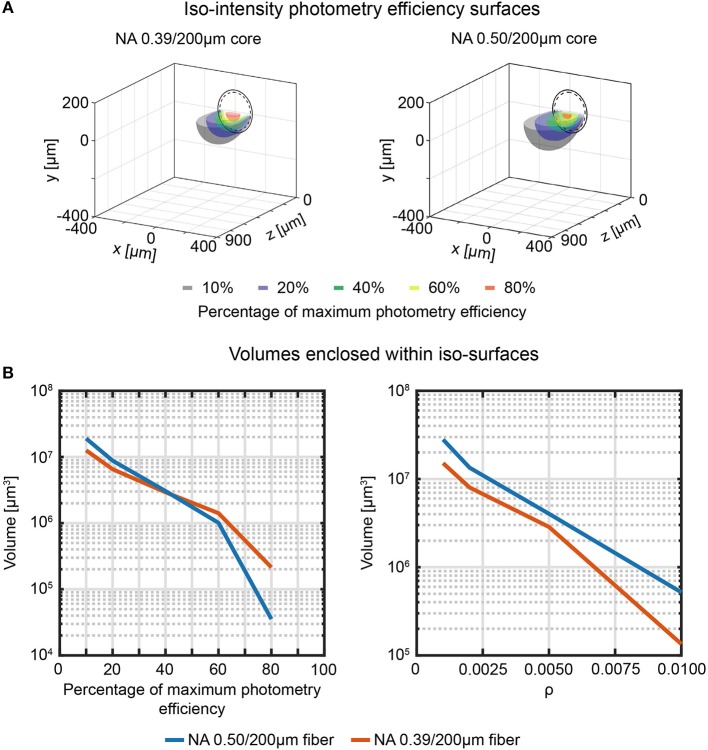
Effective fiber photometry sampling volumes in tissue. (A) Cross-sections of the 3-dimensional reconstruction of the photometry efficiency diagram of 0.39/200 μm and 0.50/200 μm fibers (left and right, respectively). Iso-intensity surfaces at 10%, 20%, 40%, 60%, and 80% efficiency are shown (in black, blue, green, yellow, and red, respectively). The continuous and dashed circles represent the cladding and the core boundaries, respectively. (B) Volumes enclosed by the iso-intensity surfaces at 10%, 20%, 40%, 60%, and 80% of the maximum photometry efficiency (left) and at ρ = 0.001, 0.002, 0.005, 0.01 (right) for 0.39/200 μm and 0.50/200 μm fibers (orange and blue curves, respectively).